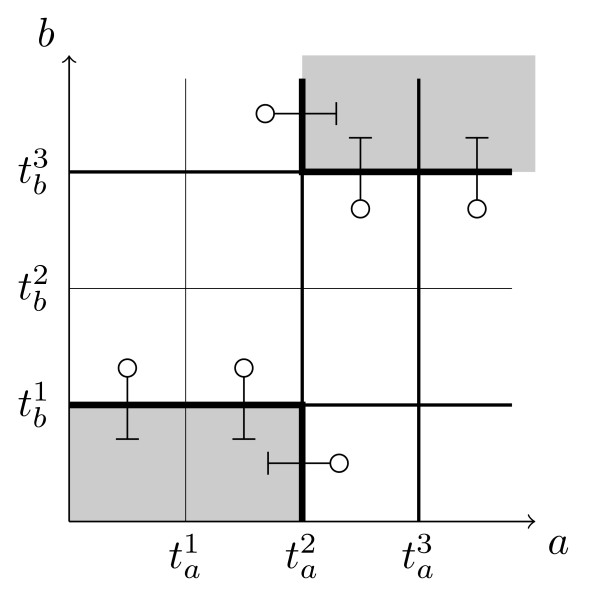
Graphical representation of  relative to example in Figure 3.